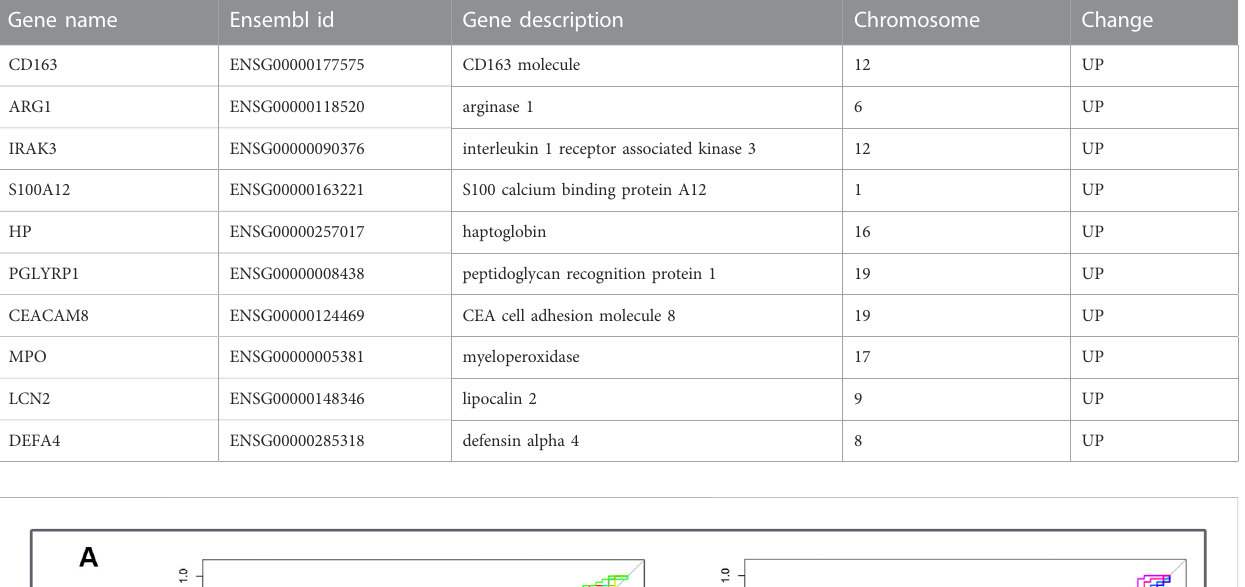
TABLE 4 The detailed information and descriptions of hub genes.